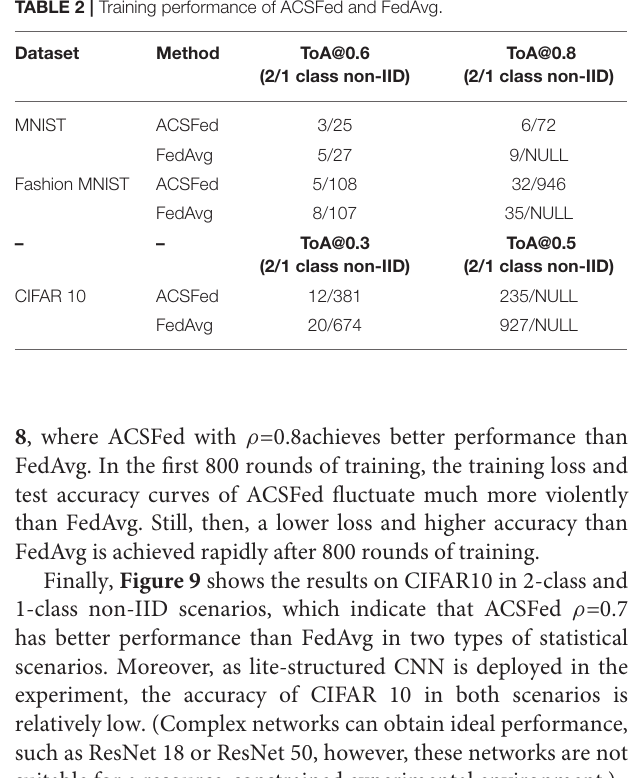
TABLE 2 | Training performance of ACSFed and